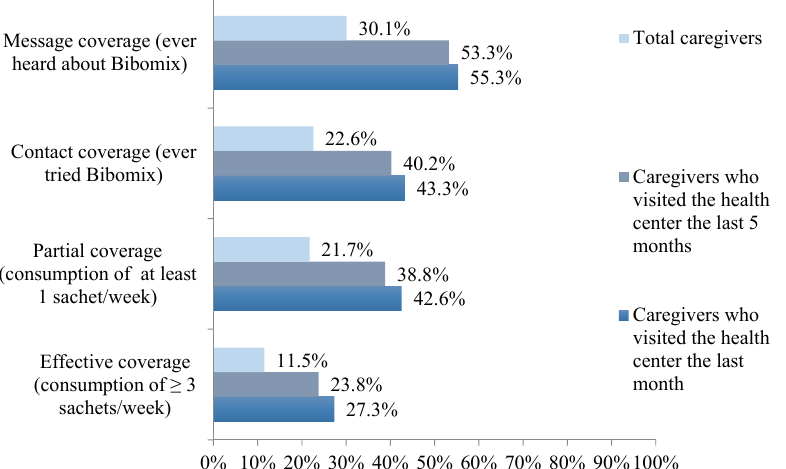
Figure 3. Coverage of the pilot in the four provinces by visit to the health centers.